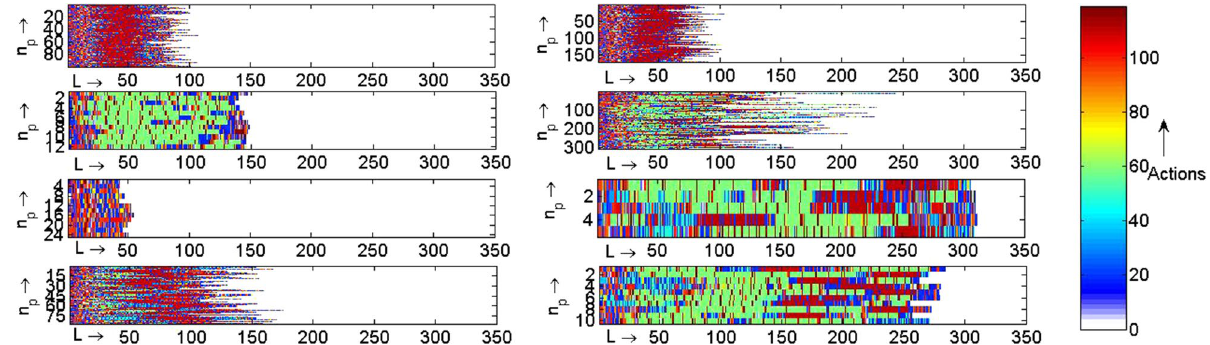
Figure 4. Cluster of sequences of visit records (activity-cost pairs) of patients with n p as number of patients and L as the length of the sequence.